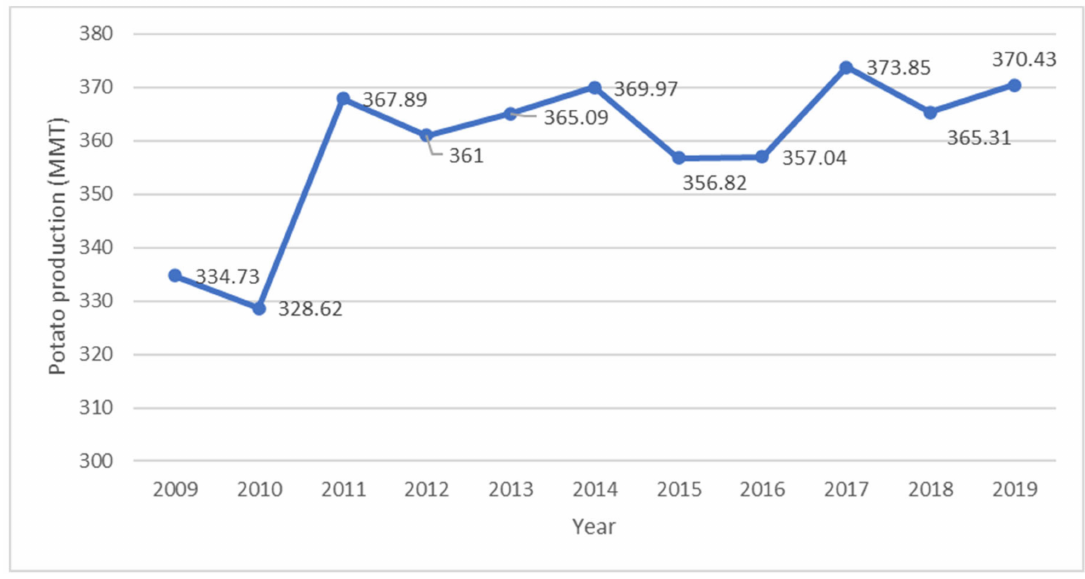
Figure 1. World potato production from 2009 to 2019